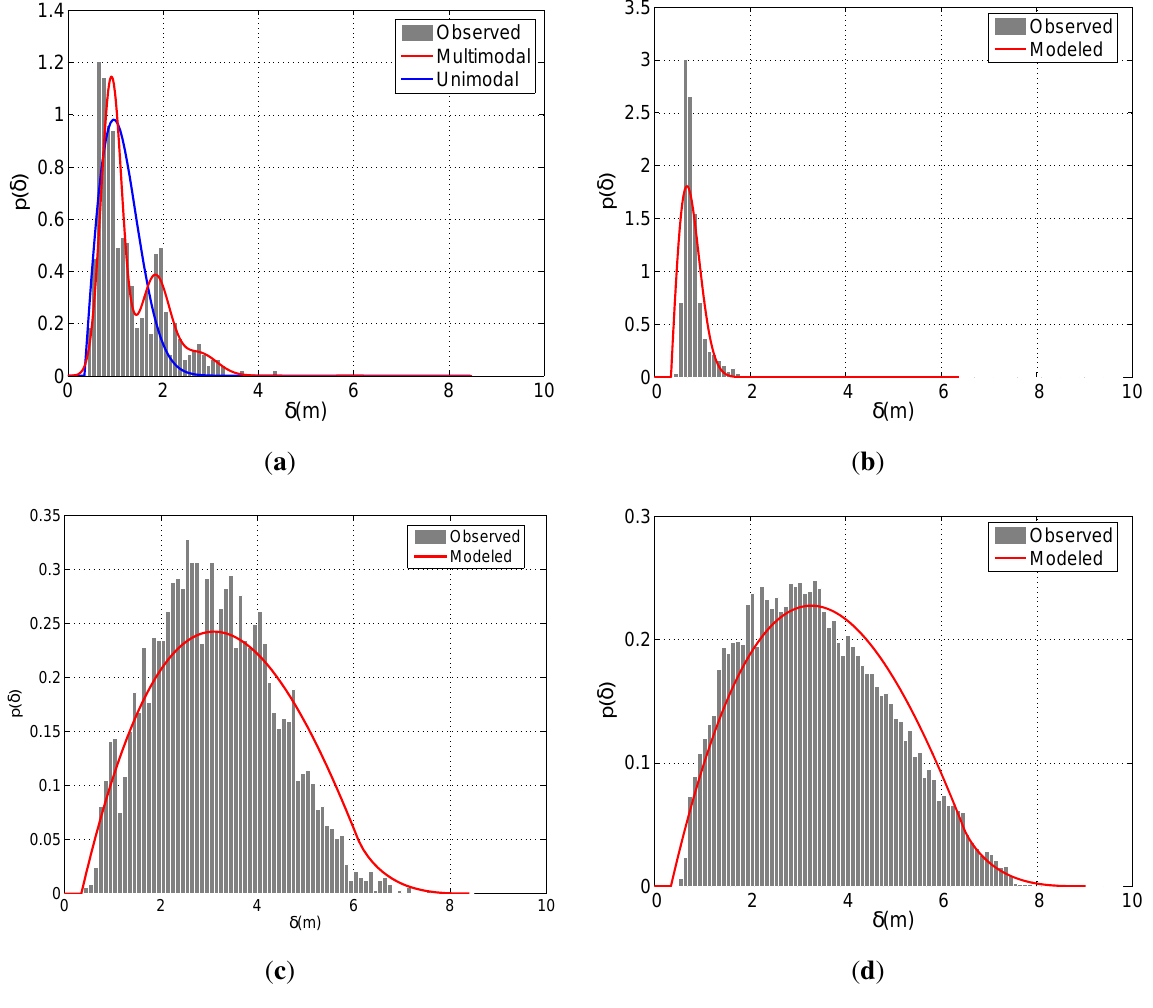
for ( a ) BIWI-ETH and G . G